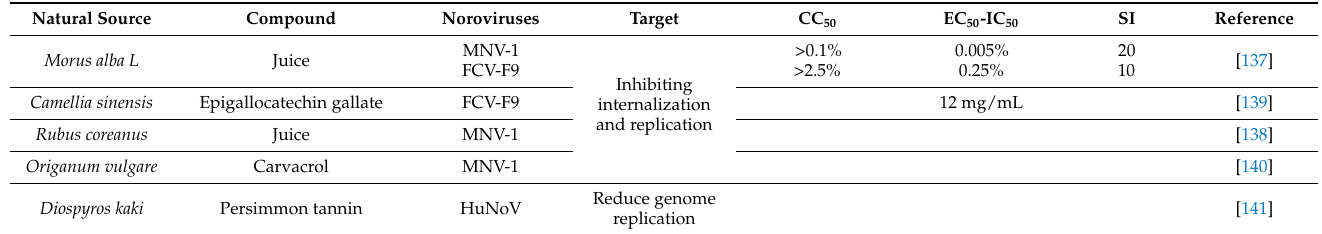
Table 9. Natural products against